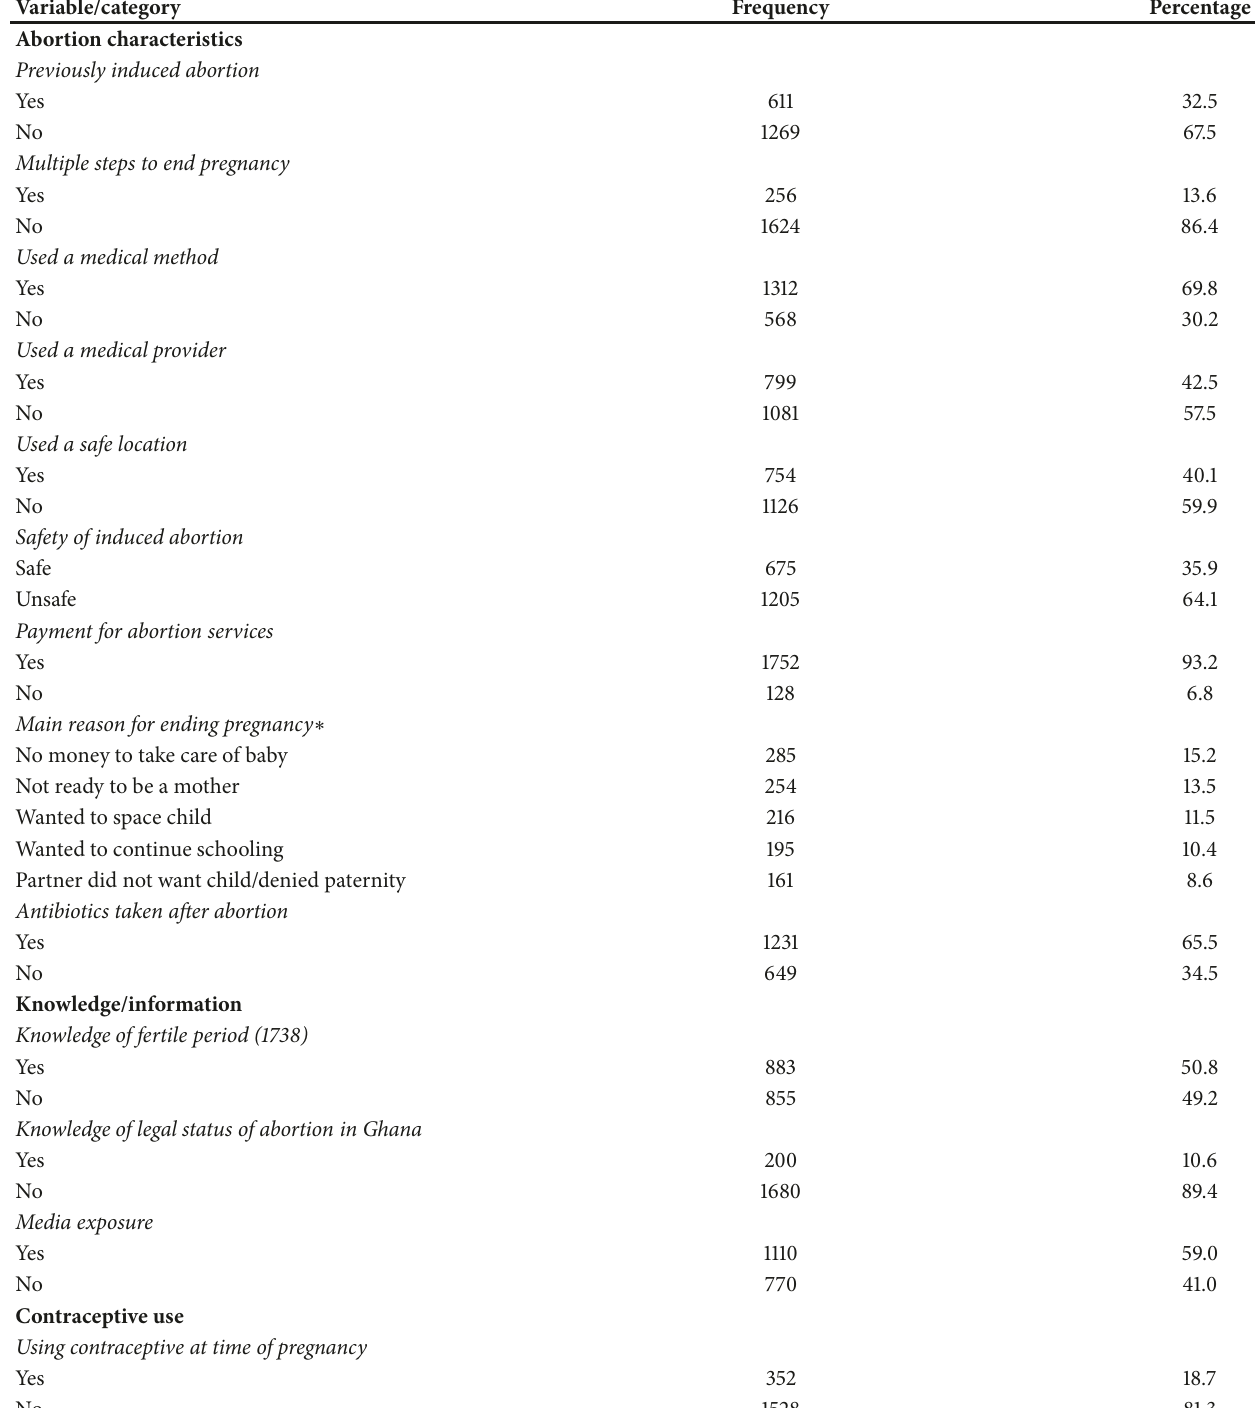
Table 2: Distribution of respondents by abortion characteristics, knowledge/information, and contraceptives use.